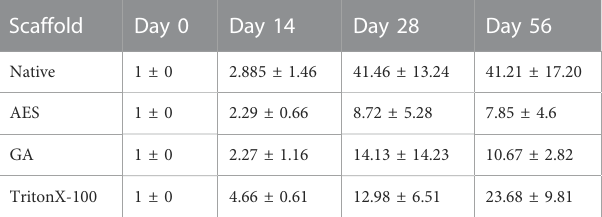
TABLE 2 Expression level of graft-speci fi c humoral adaptive immune response in each group.